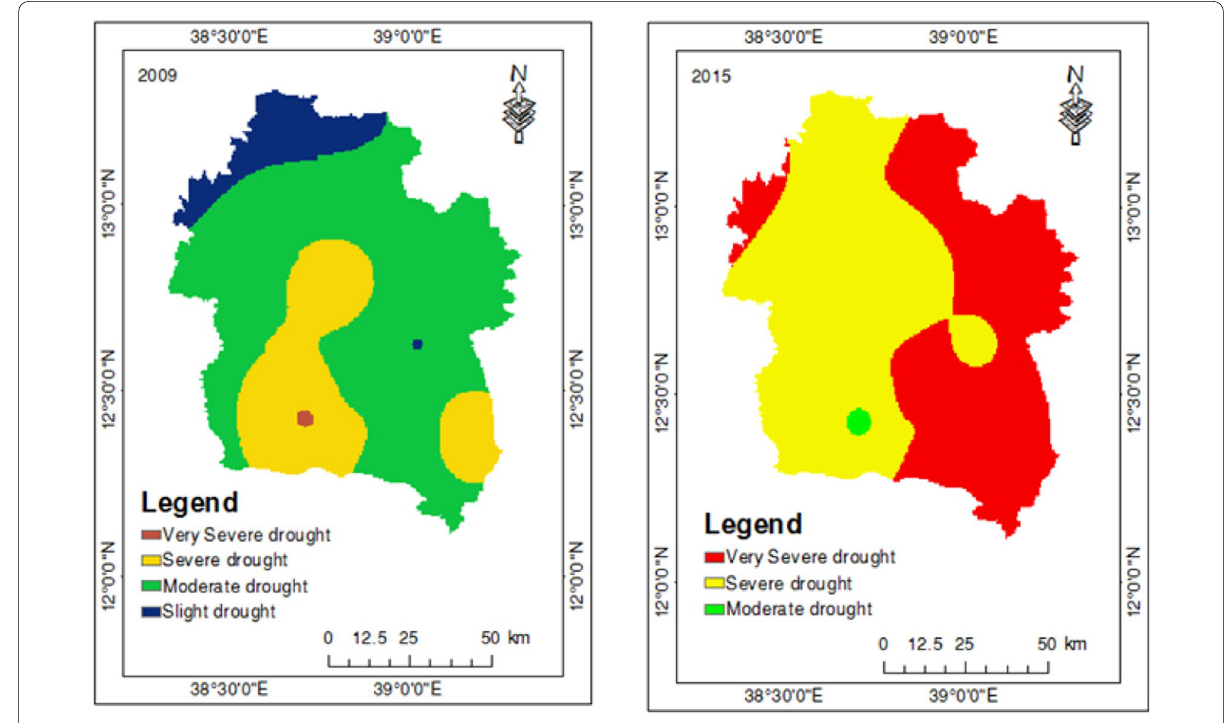
Fig. 12 Standard Precipitation Index for drought year 2009 and 2015